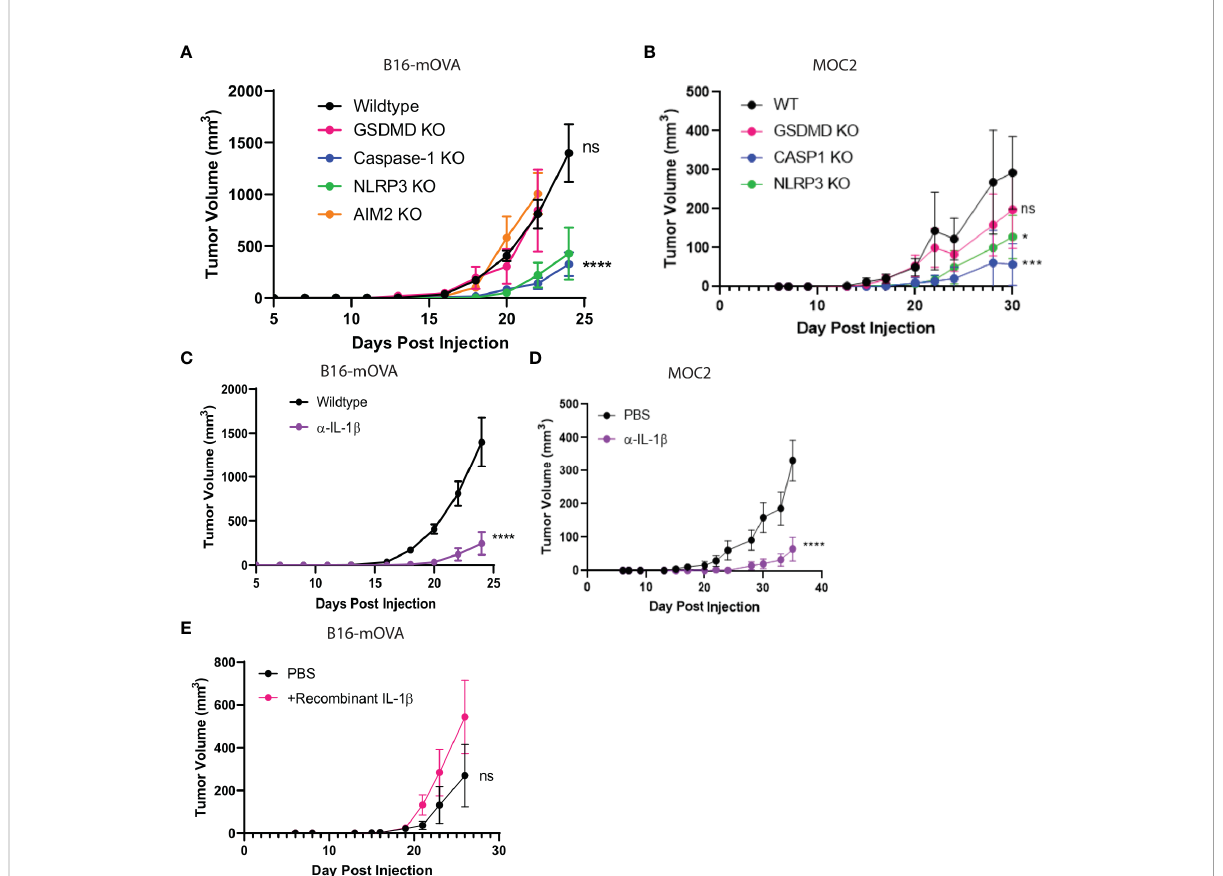
FIGURE 1 NLRP3/Casp-1/IL-1 b axis drives tumor growth. (A, B) The in fl ammasome sensor, NLRP3, and caspase-1 drive tumor growth. B16-mOVA (A) and MOC2 (B) tumor growth shown in GSDMD, caspase-1, AIM2, and NLRP3 global knockout mice as compared to tumor volume in WT mice. (n=5 mice/group). (C, D) IL-1 b promotes B16-mOVA (C) and MOC2 (D) tumor growth as shown by a reduction in tumor volume upon IL-1 b depletion compared to control PBS treated mice. Mice treated with 100 µg of IL-1 b depleting monoclonal antibody or control 100 µl PBS 2x/ week (n= 10 mice/group). (E) Increased IL-1 b drives B16-mOVA tumor growth. Mice treated with 5 ng recombinant IL-1 b or control 100 µl PBS 2x/week (n=5 mice/group). All statistics represent two-way ANOVA and all error bars represent SEM. (*p < 0.05, ***p < 0.001, ****p < 0.0001; ns, not signi fi